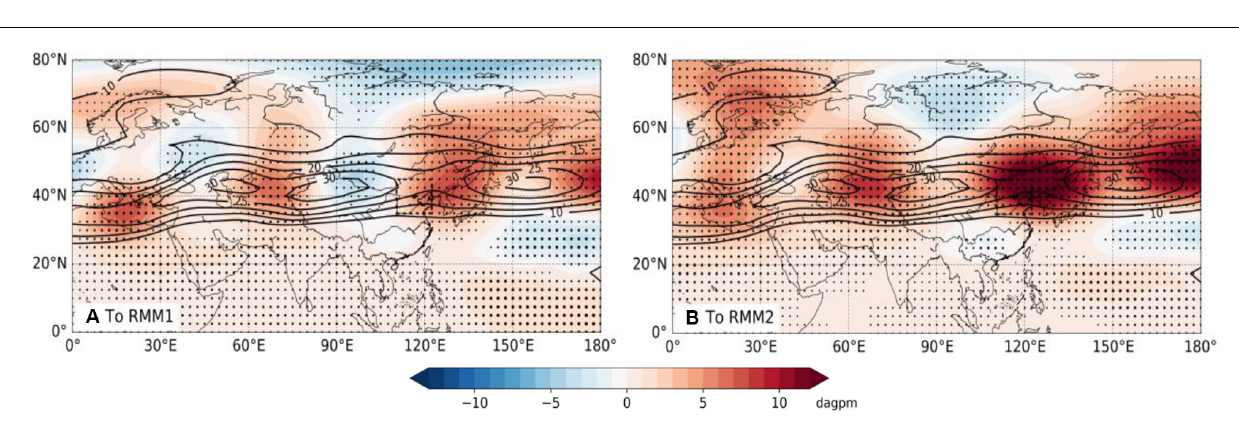
FIGURE 11 | The regressed pattern of anomalous height at 200 hPa onto (A) RMM1 and (B) RMM2 in the summer of 2018 (the dotted areas exceed 95% confidence level; unit: dagpm). The contour lines are the averaged zonal wind velocity u at 200 hPa in the summer of 2018 (unit: m · s − 1